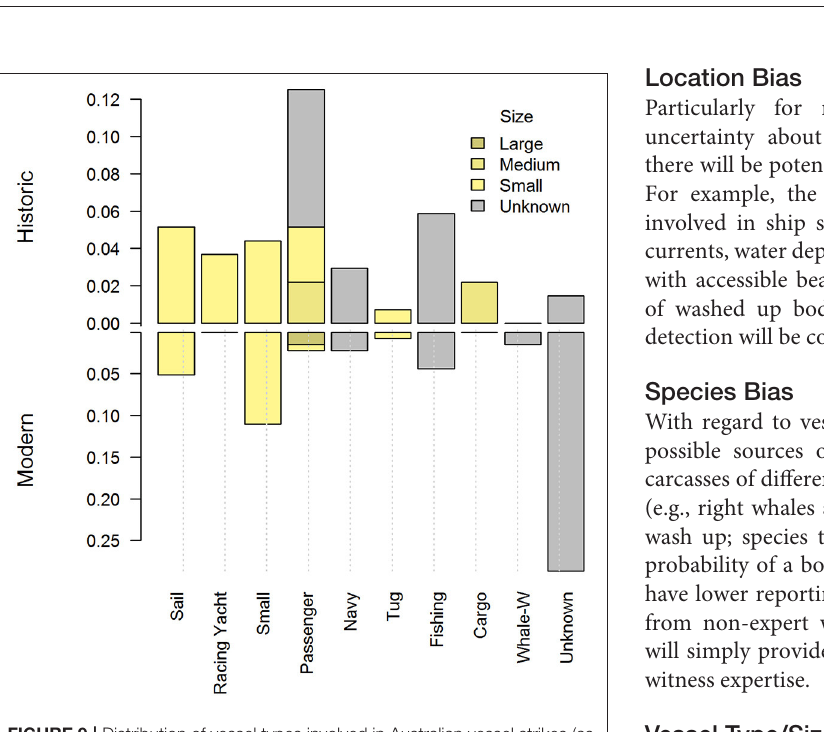
FIGURE 9 | Distribution of vessel types involved in Australian vessel strikes (as proportion of total), divided into approximate sizes: small ( ∼ < 25m), medium ( ∼ 25–150m) and large ( > 150m). Historic pre-1997 (upper) and modern 1997 onwards